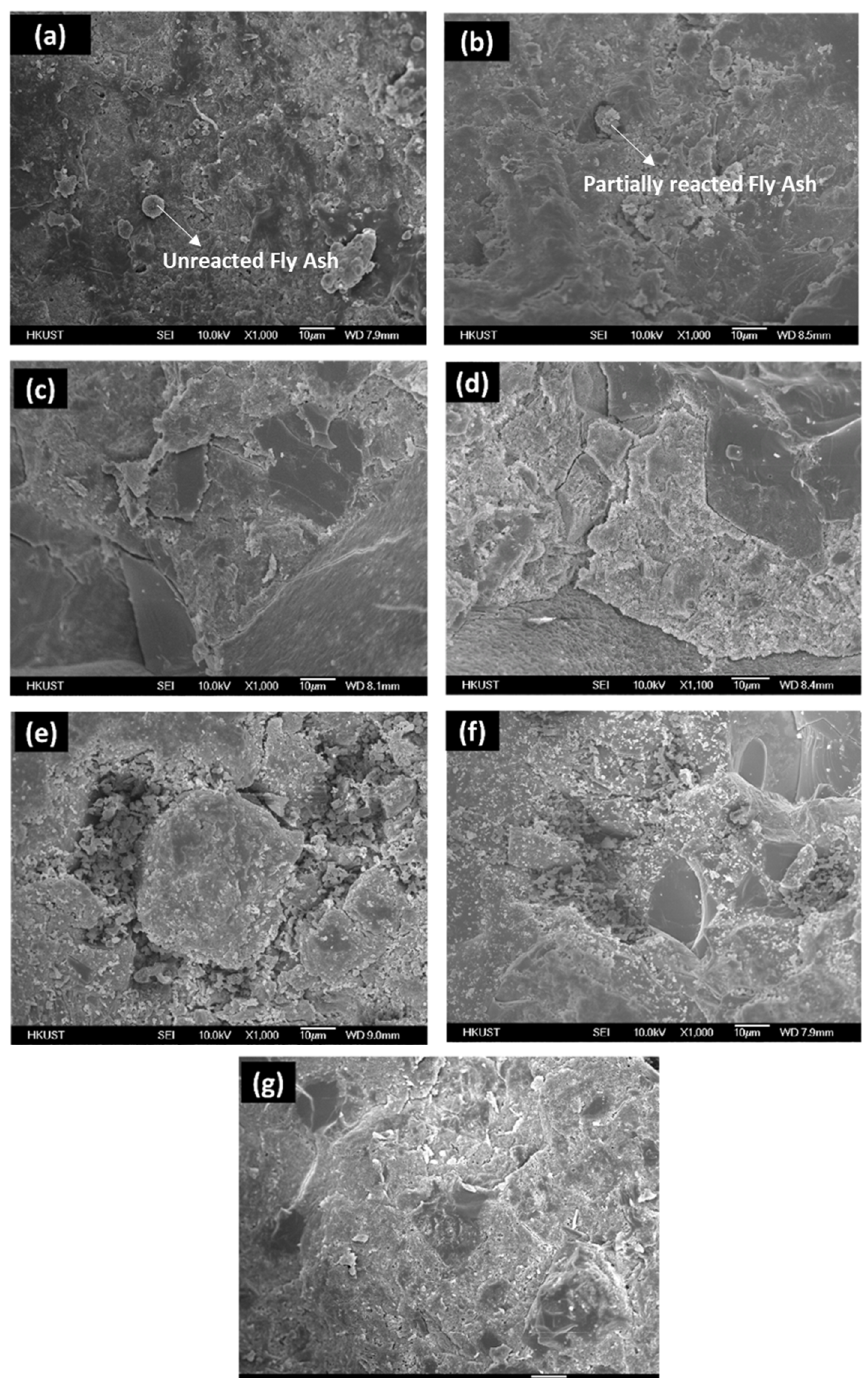
Figure 7. Scanning electron micrographs of mortar composites ( a ) T 0 , ( b ) T 1 , ( c ) T 2 , ( d ) T 3 , ( e ) T 4 , ( f ) T 5 and ( g ) T